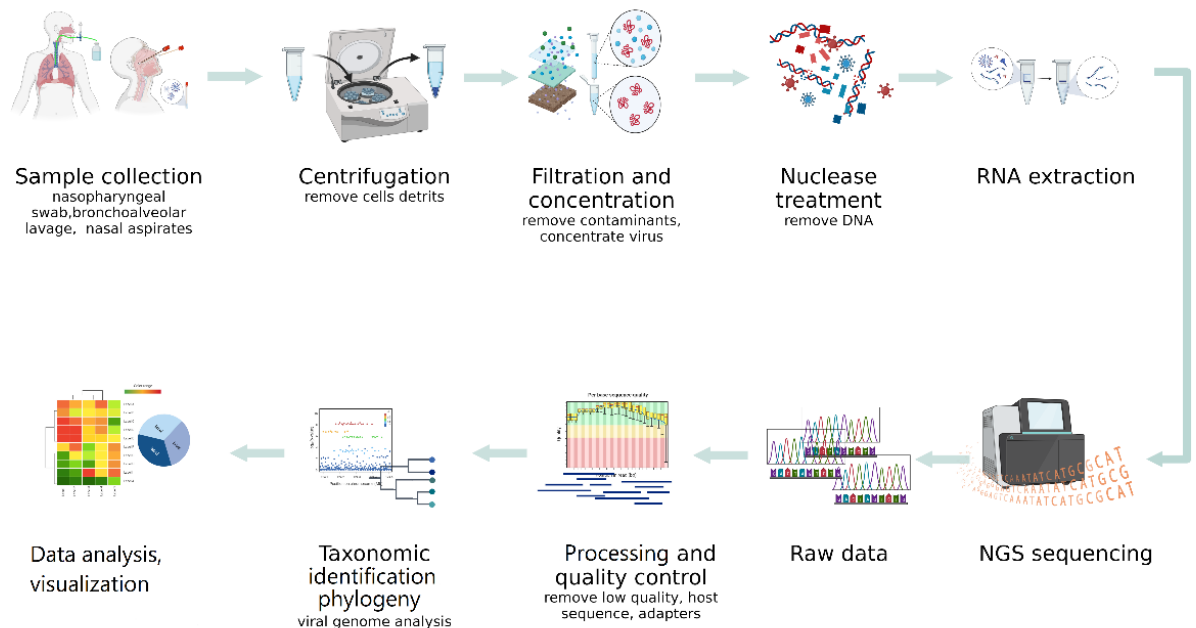
Figure 2. General scheme for NGS sequencing of respiratory